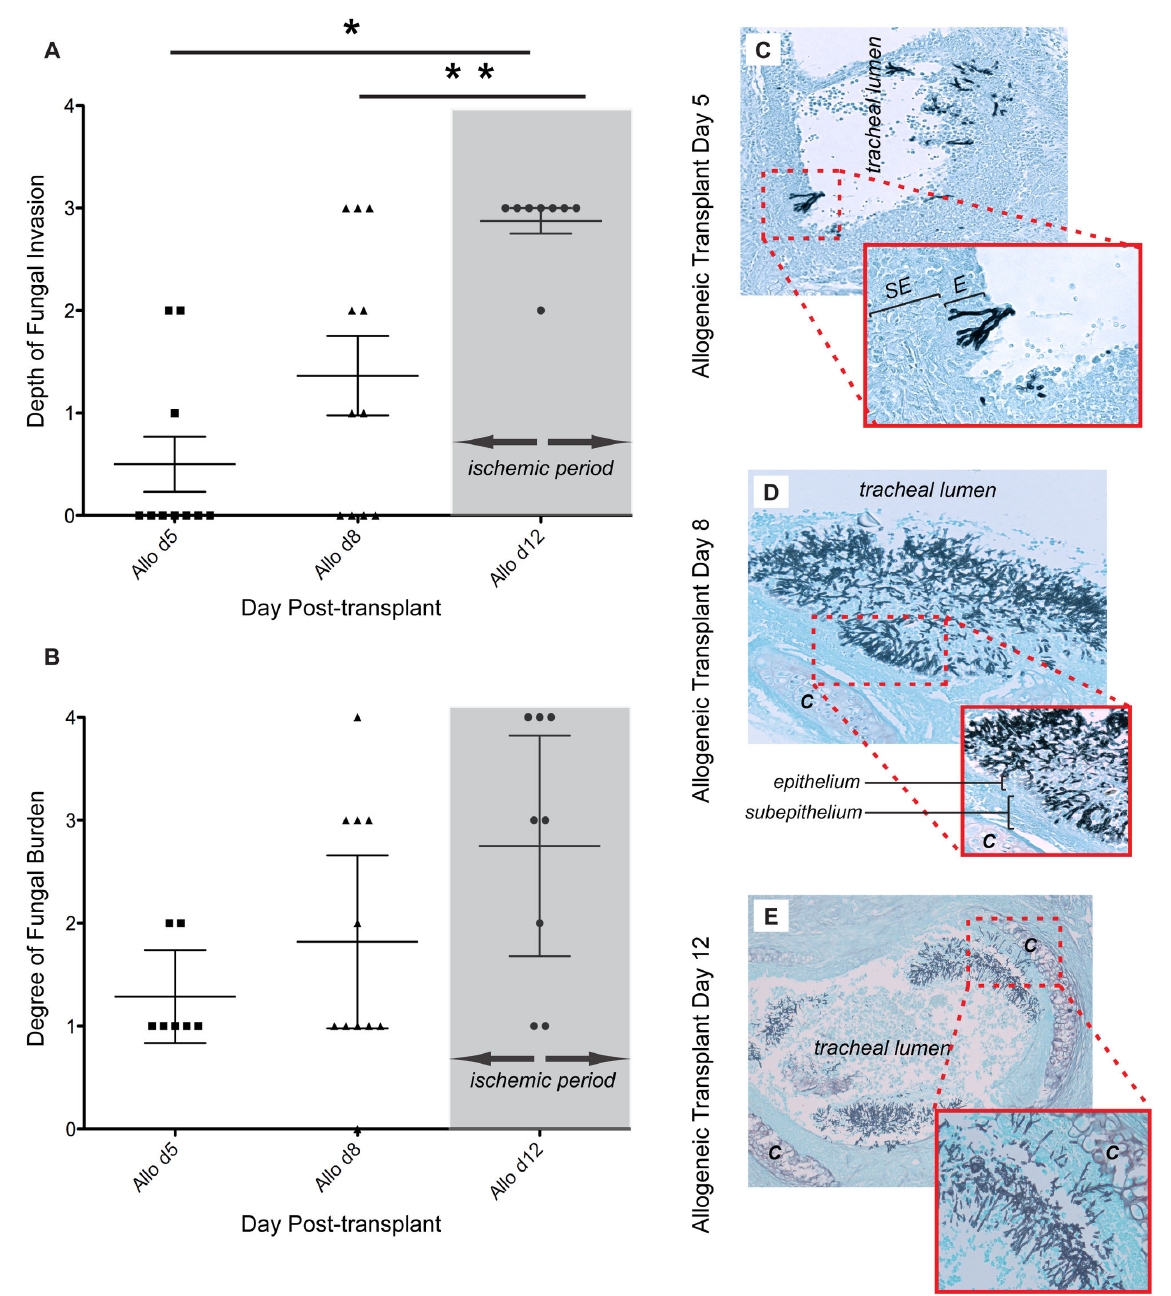
Figure 6. Aspergillus fumigatus invasion increases with allograft tissue ischemia. ( A ) Depth of fungal invasion, as measured on a semiquantitative scale 0-4 (Figure S2A, mean, 95% confidence interval (CI)), (n = 8-11 animals/time period) by day post- allotransplant. Mean depth of invasion increases from day 5 to day 12, as animal enters ischemic period (day 10-12, as illustrated by shaded gray area) [18]. *p<0.05 between days 5 and 12, **p<0.05 between days 8 and 12. ( B ) Degree of fungal burden, as measured on a semiquantitative scale 0-4 (Figure S2B, mean, 95% CI), (n = 7-11 animals/time period) by day post-allotransplant. Fungal burden increases, albeit not significantly, as animal enters ischemic period (day 10-12, as illustrated by shaded gray area) [18]. ( C - D ) Representative GMS-histopathology of longitudinal sections for ( C ) day 5 (10X magnification), inset (40X magnification) and ( D ) day 8 (20X magnification), inset (40X magnification). ( E ) Day 12 transverse section illustrates deeply invasive infection (grade 3) to the level of the cartilaginous ring (10x magnification) inset (20X magnification). “ C ” denotes cartilaginous ring, “ E ” specifies epithelial layer, “ SE ” specifies subepithelial layer. doi: 10.1371/journal.pone.0077136.g006 PLOS ONE |